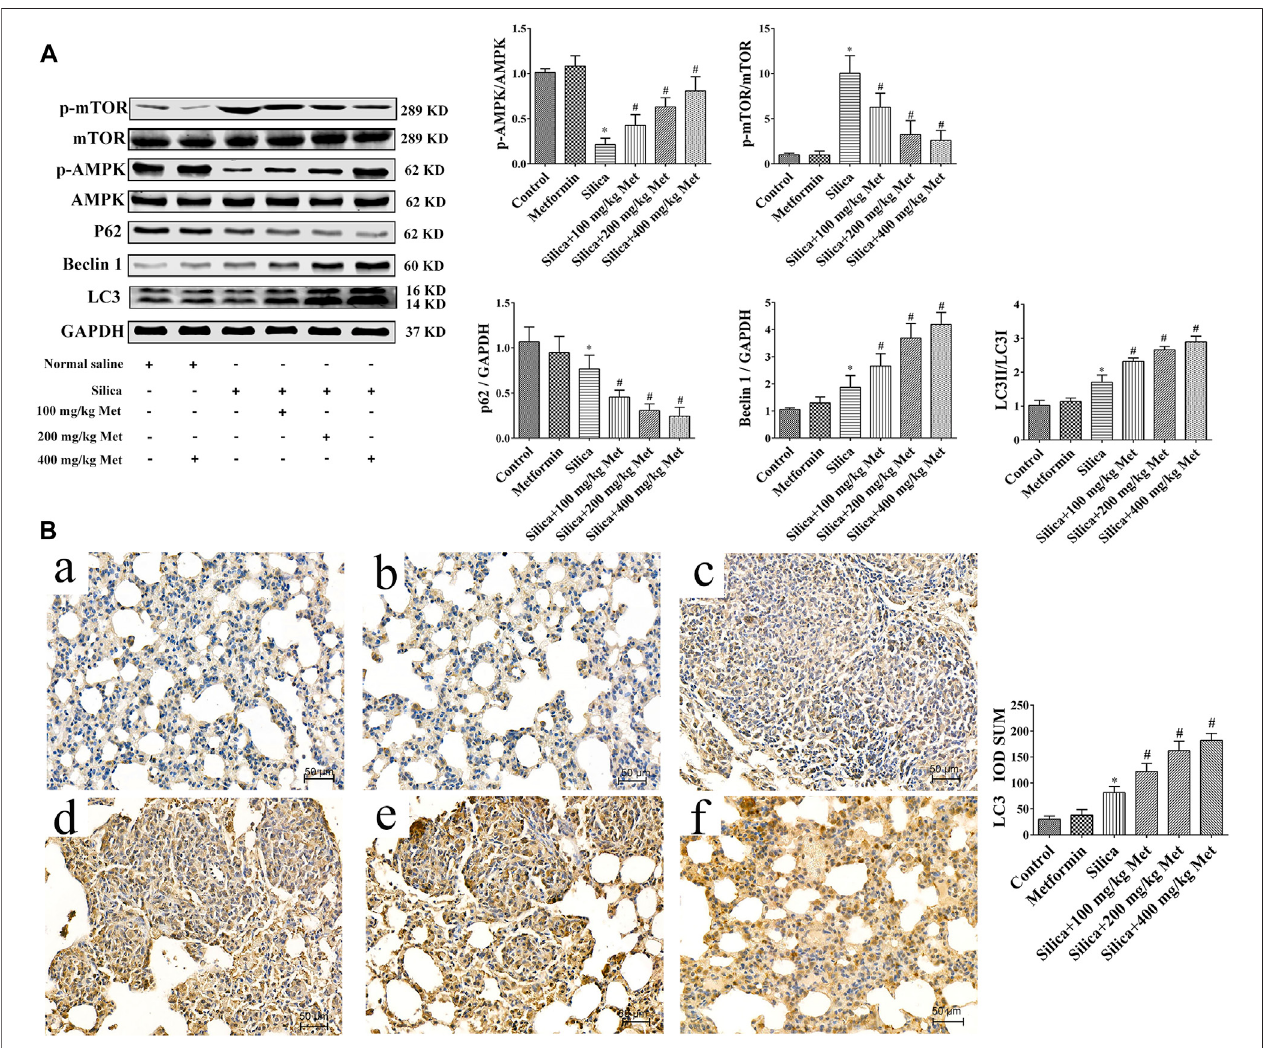
FIGURE 4 | Metformin activates autophagy via the AMPK-mTOR signaling pathway. (A) The protein levels of AMPK, p-AMPK, mTOR and p-mTOR, p62, Beclin1, and LC3 in lung tissues of rats by western blot. (B) The protein levels of LC3 was determined by Immunohistochemistry (200 × mag.). a Control group; b Metformin treatment group; c Silica group; d Silica+100 mg/kg metformin group; e Silica+200 mg/kg metformin group; f Silica+400 mg/kg metformin group. All the data are presented as mean ± SD (n (cid:2) 8 for each group). * p < 0.05, compared to the negative control group; # p < 0.05, compared to silica group. AMPK, adenosine5 ′ - monophosphate (AMP)-activated protein kinase; mTOR, mammalian Target of Rapamyc; LC3, microtubules associated protein 1 light chain 3; Met, metformin.